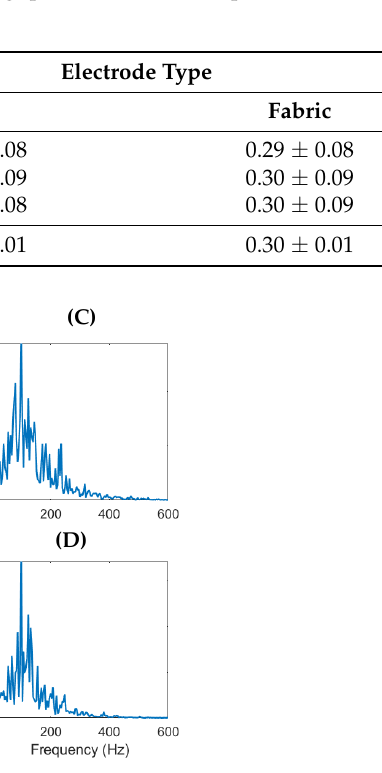
Figure 6. Example of recorded high-pass filtered signals from 4th gel and embroidered offline sessions of subject 1. EMG from gel electrodes ( A ) and embroidered electrodes ( B ). Power spectra of gel ( C ) and embroidered ( D ) signals. Samples of each gesture are four seconds in length, and gestures used, in order, are open hand, closed hand, relax, wrist extension, and wrist flexion. Y -axis are of arbitrary units.